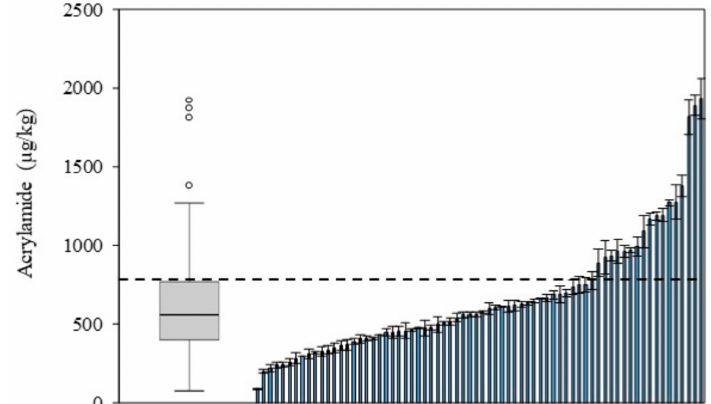
Figure 1. Box and whisker plot and distribution graph for the acrylamide content in Spanish potato crisps. Symbols: ◦ outliers. The dotted line indicates benchmark level (750 µ g / kg) established by the European Commission